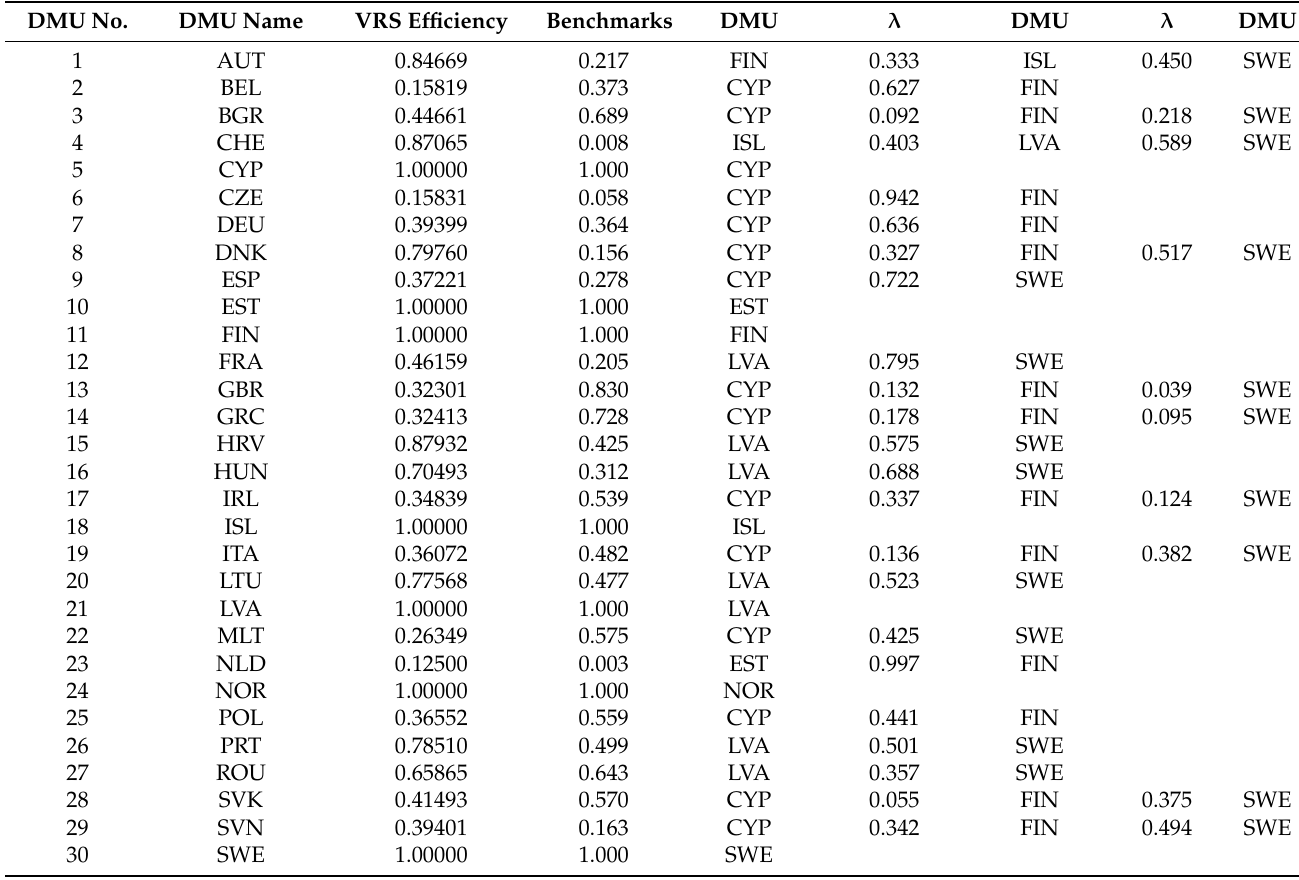
Table A8. Input-Oriented VRS Efficiency of EPS in 2011. Source: Authors’ calculations in DEAFrontier. DMU